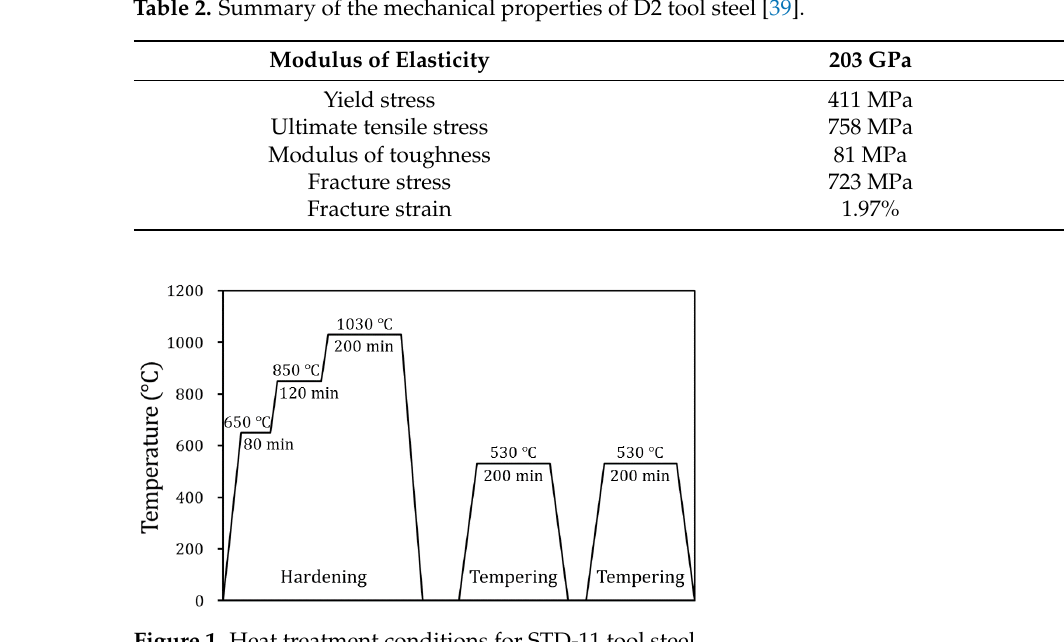
Table 1. Summary of the mechanical properties of a TRIP 1180 steel sheet obtained using uniaxial